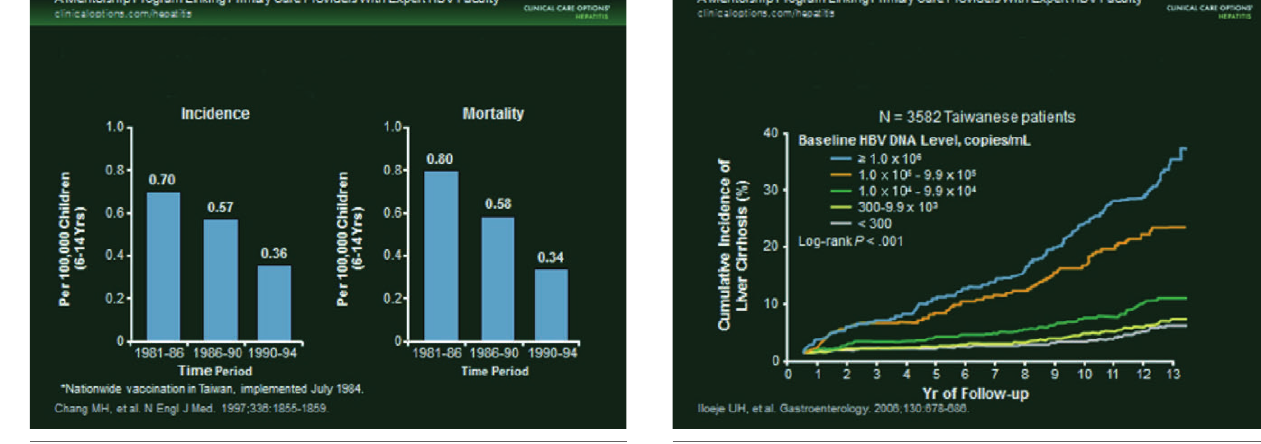
Figure 4. Effect of HBV vaccination on HCC incidence and mor- tality.